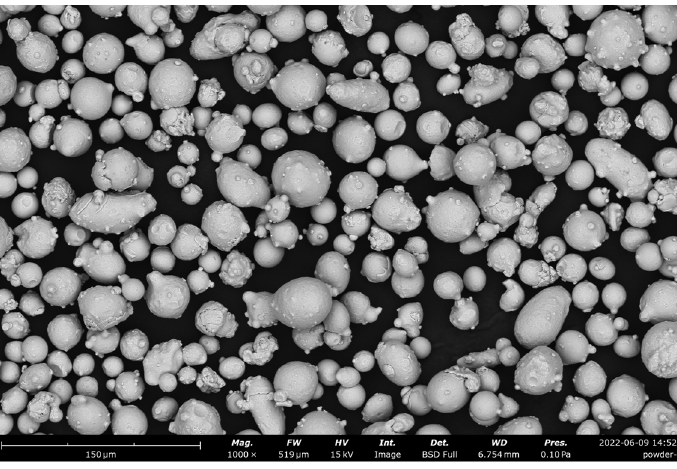
Figure 1. EHLA system.